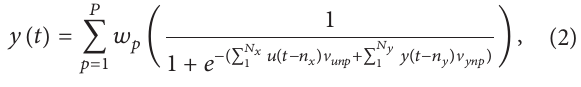
can be divided into two parts, namely, (1) inverse controller and (2) reactor model. The reference signal 𝑟(𝑡) of DIC is the power level setpoint of the reactor and the output of inverse controller is the position of the control rod, that is, the regulator rod position 𝑢 1 (𝑡) and bank rod position 𝑢 2 (𝑡)